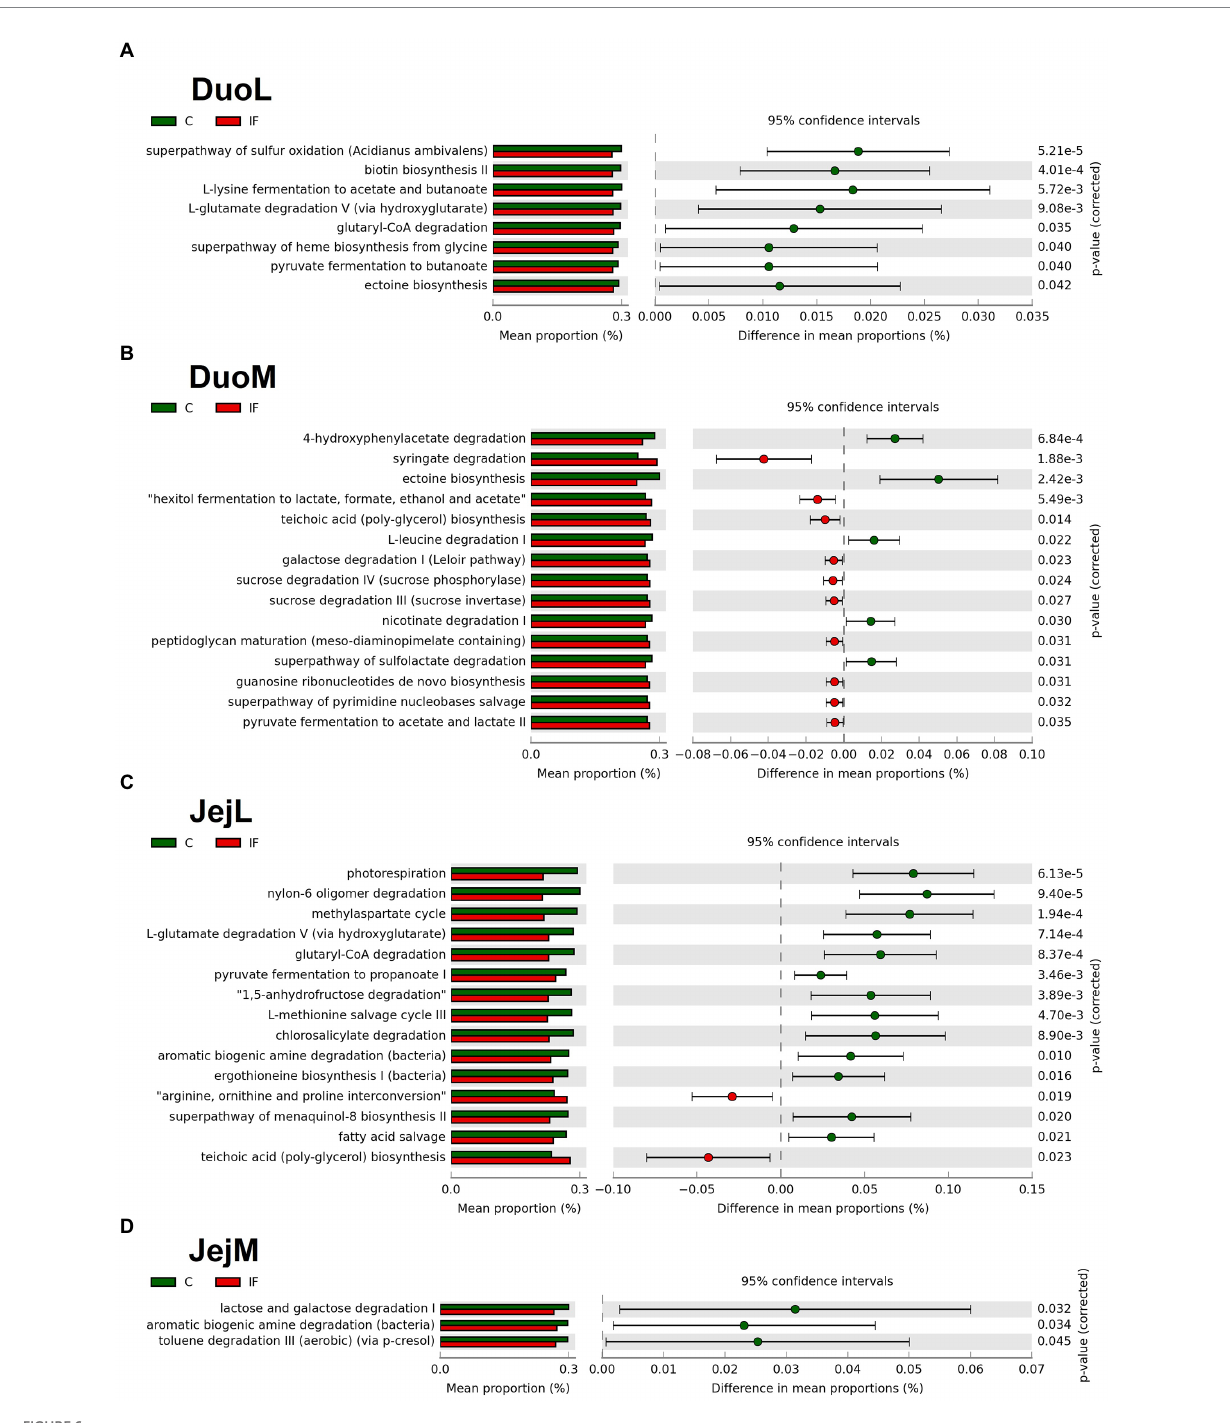
FIGURE 6 Effect of Eimeria acervulina -infection on mean proportion (%) of predicted MetaCyc pathways (up to the top 15 shown) in the (A) duodenal luminal (DuoL), (B) duodenal mucosal (DuoM), (C) jejunal luminal (JejL), and (D) jejunal mucosal (JejM) bacterial